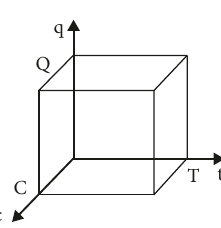
Figure 1: The planned value of activity 𝑘 of project j .